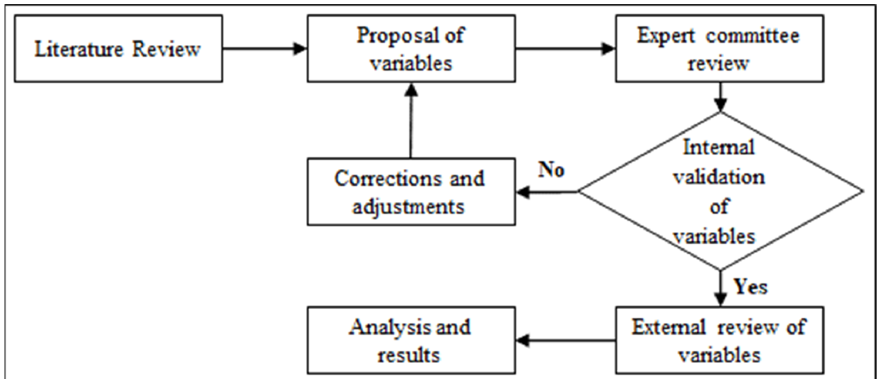
Figure 1. The process to define the classification variables.